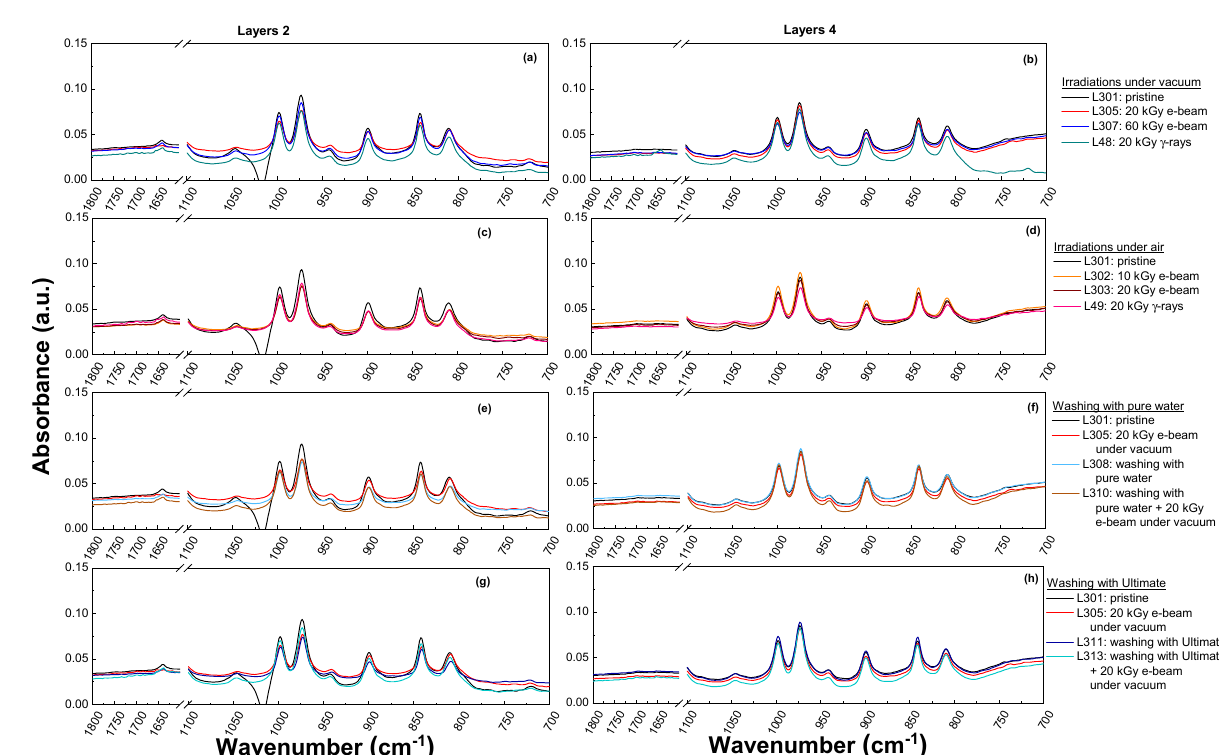
Figure 3. Infrared spectra of layer 2 and layer 4 of the Valmy FFP2 mask in ATR mode, before and after different sterilization protocols. Zoomed-in depictions of the 1800–1600 cm − 1 (C=O area) and 1100–700 cm − 1 (C=C area) areas. Line 1: irradiations under vacuum ( a : Layer 1; b : Layer 3). Line 2: irradiations under air ( c : Layer 1; d : Layer 3). Line 3: washing with pure water, followed by irradiation using e-beam under vacuum or not ( e : Layer 1; f : Layer 3). Line 4: washing with